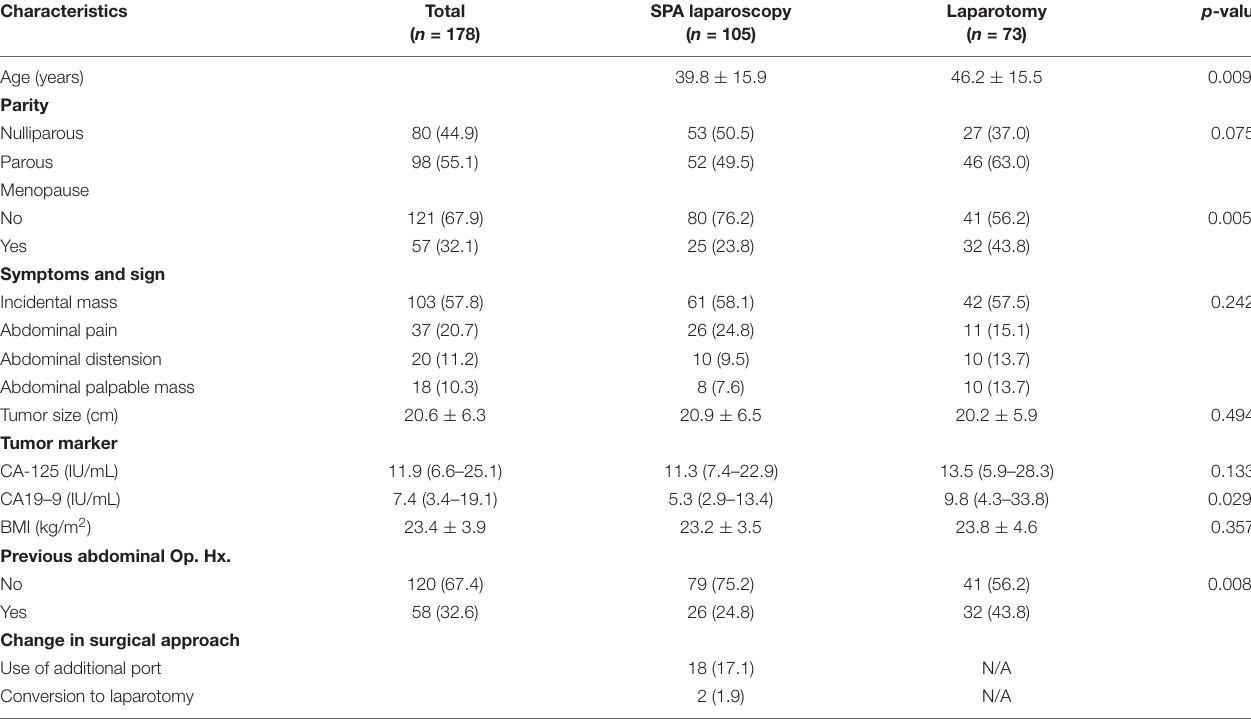
TABLE 1 | Baseline characteristics of the